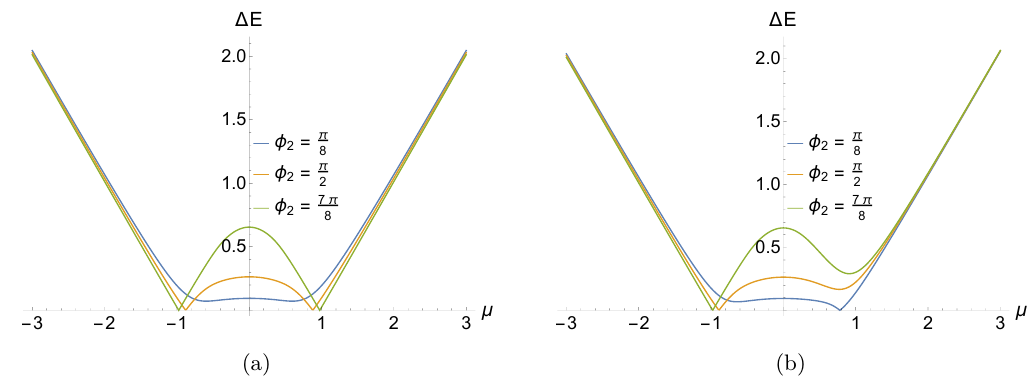
Figure 7 . The energy gap between the ground state and first excited as a function of µ with ∆ = J = 1 , a = b = 1 . We have fixed φ we note a pair of values for µ exhibit a closing energy gap provided | φ is L = 9 . In this case we observe only a single value for µ for which gap closing occurs.